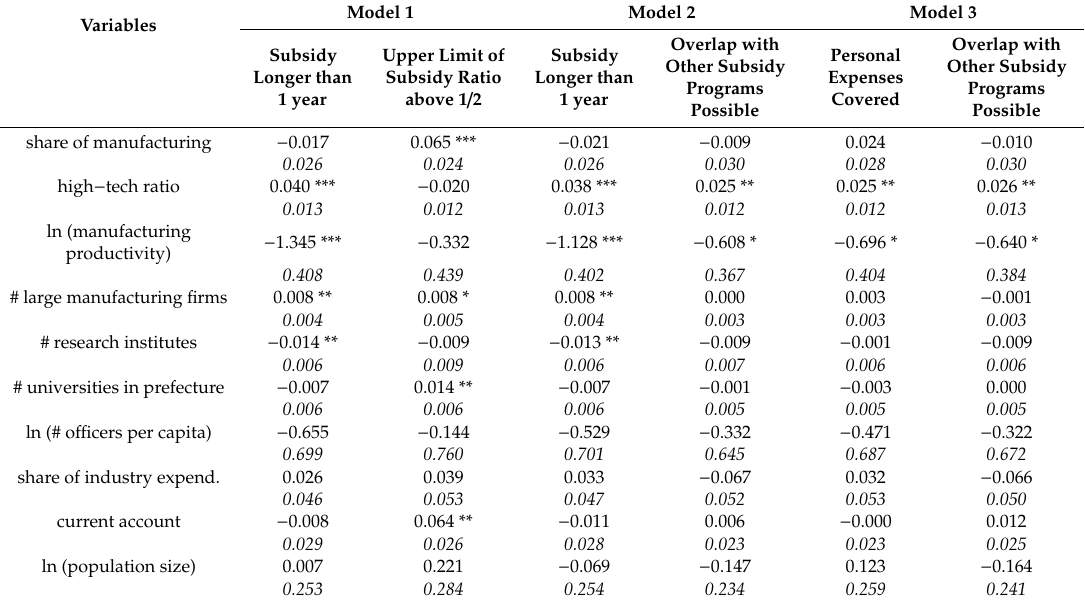
Table 9. Bivariate probit